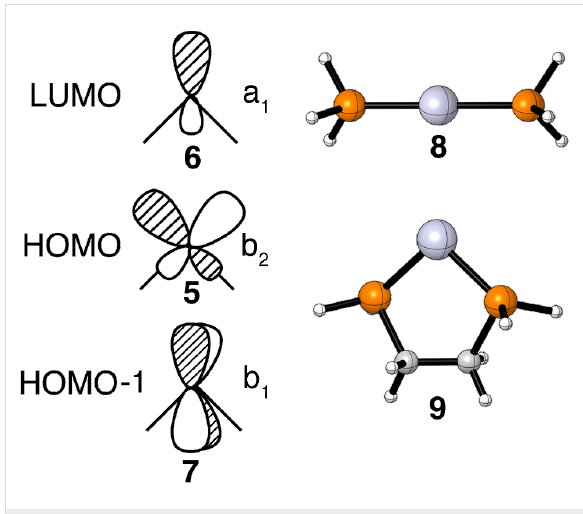
Figure 2: The important valence orbitals of a d 10 ML 2 group, 5 – 7 , along with the computed structures of Pt(PH 3 ) 2 and Pt(dpe).